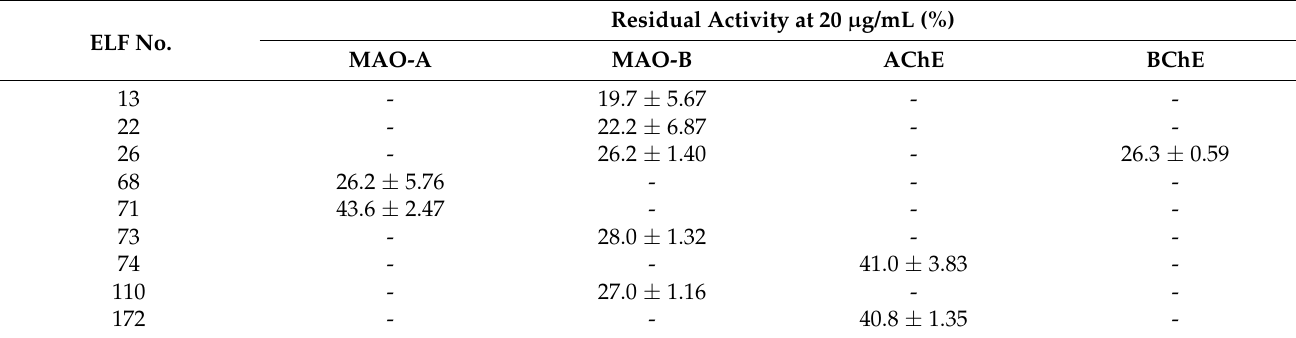
Table 1. Inhibitory activities of monoamine oxidase-A (MAO-A), MAO-B, acetylcholinesterase (AChE), and butyryl- cholinesterase (BChE) by endogenous lichen fungi (ELF) extracts. ELF No.